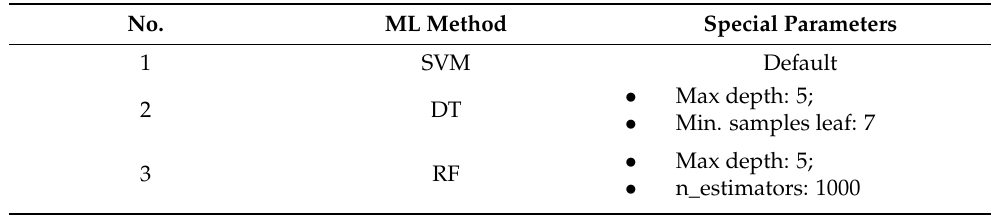
Table 1. The Architectures of AI